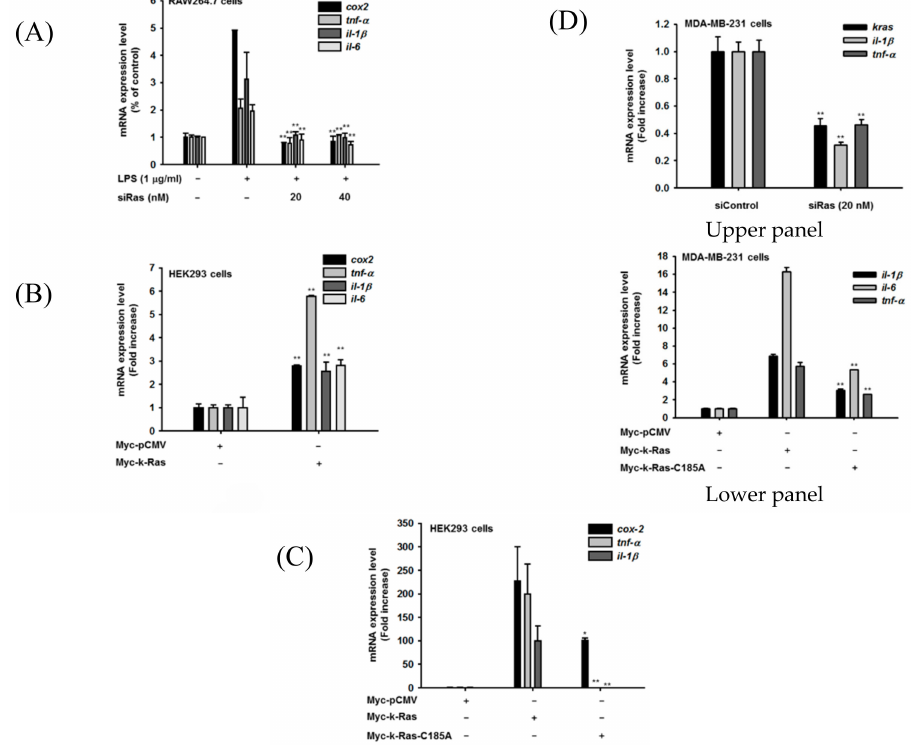
Figure 3. ICMT-mediated inflammatory responses are mediated by Ras. ( A ) The mRNA levels of inflammatory genes ( COX-2 , TNF- α , IL-1 β , and IL-6 ) in RAW264.7 cells treated with 1 µ g / mL of LPS in the presence or absence of siRas were determined by real-time PCR. ( B , C ) The mRNA levels of inflammatory genes ( COX-2 , TNF- α , IL-1 β , and IL-6 ) were also determined in HEK293 cells transfected with Myc-k-Ras or Myc-k-Ras-C185A using real-time PCR. (( D ), upper and lower panels) The mRNA levels of K-RAS and inflammatory genes ( IL-6 , TNF- α , and IL-1 β ) in MDA-MB-231 cells treated with siRNA to Ras (left panel) or transfected with Myc-k-Ras or Myc-k-Ras-C186A (right panel) were determined by real-time PCR. *: p < 0.05 and **: p < 0.01 compared to the normal group, LPS-treated group, or Myc-k-Ras-transfected